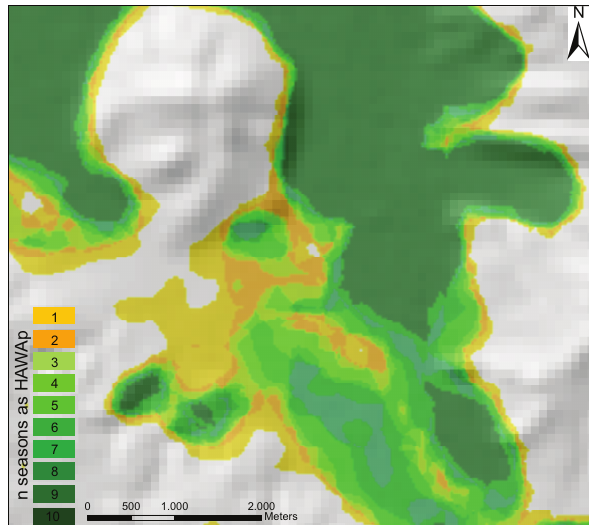
Fig. 10. Annual changes in spatial extend of HAWA P . Numbers in coloured rectangular boxes indicate number of years where areas were mapped as HAWA P